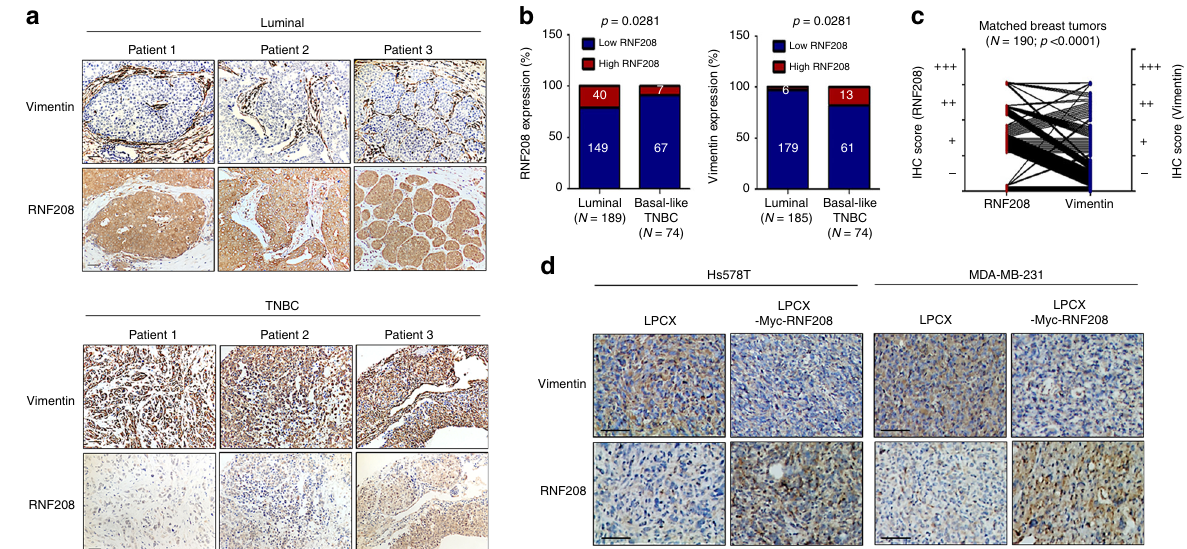
Fig. 5 RNF208 expression is inversely correlated with Vimentin expression in patients with breast cancer. a Representative IHC images showing the expression of RNF208 and Vimentin in luminal subtype or TNBC patient tumor tissues. Original magni fi cation, ×100. Scale bar, 50 μ m. b The stacked bar charts showing the expression of RNF208 and Vimentin from TMAs of breast cancer patients (Luminal for RNF208 ( N = 189), Vimentin ( N = 185) and basal-like TNBC N = 74). P values were calculated by Fisher exact test. Numbers in the bar charts indicate the number of patients according to IHC intensity scores. c The graph showing the RNF208 and Vimentin IHC intensity in matched tumors from TMAs of breast cancer patients ( N = 190). P values were calculated by paired two-tailed Student ’ s t tests. d Representative IHC images showing RNF208 and Vimentin expression in primary tumor tissues from Fig. 3b. Original magni fi cation, ×100. Scale bar, 50 μ m. Source data for ( b , c ) are available in Source Data fi